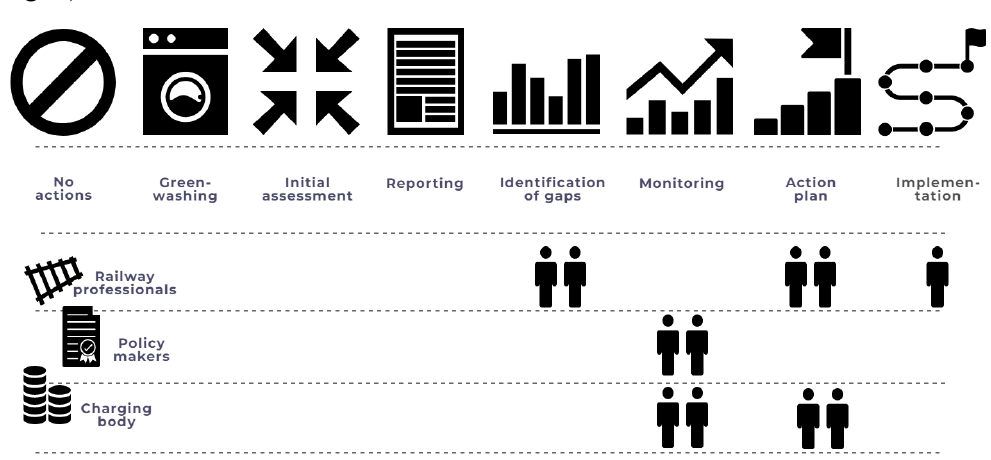
Fig. 1. Experience of focus group participants with ESG